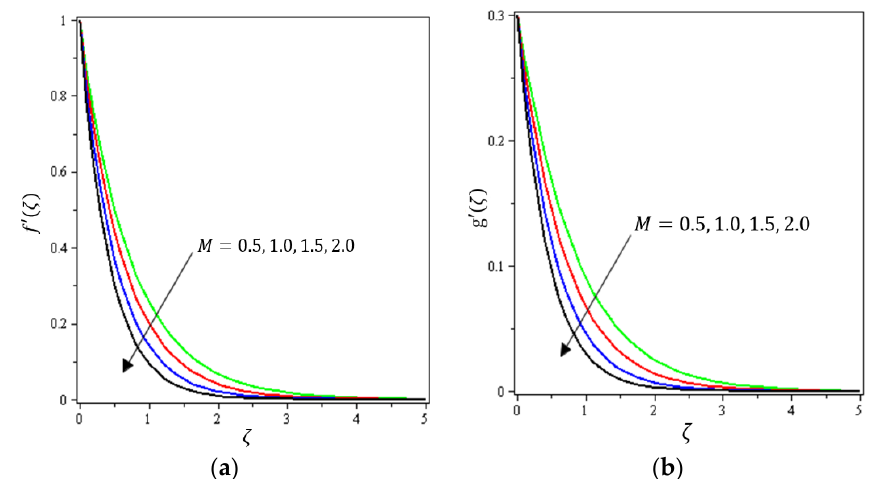
Figure 2. Influence of magnetic field 𝑀 on velocities ( a ) 𝑓′(𝜁) and ( b ) g ′(𝜁) .